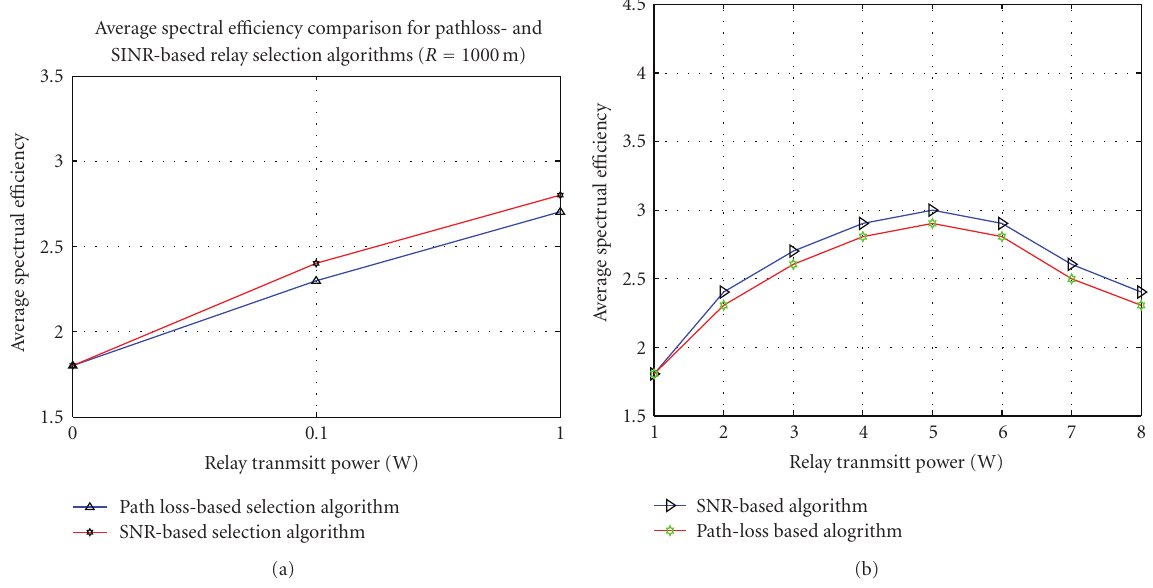
Figure 9: (a) Path-loss versus SINR-based algorithm. (b) Path-loss versus SINR-based algorithm.